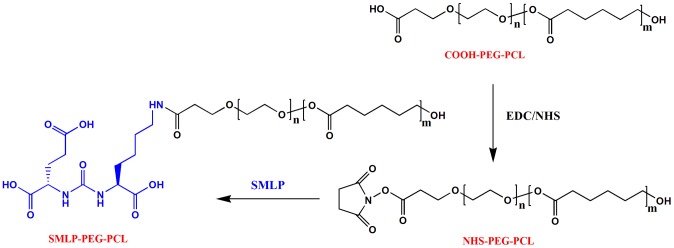
Synthetic representation of the chemical reaction for preparation of PCL-PEG-SMLP copolymer.